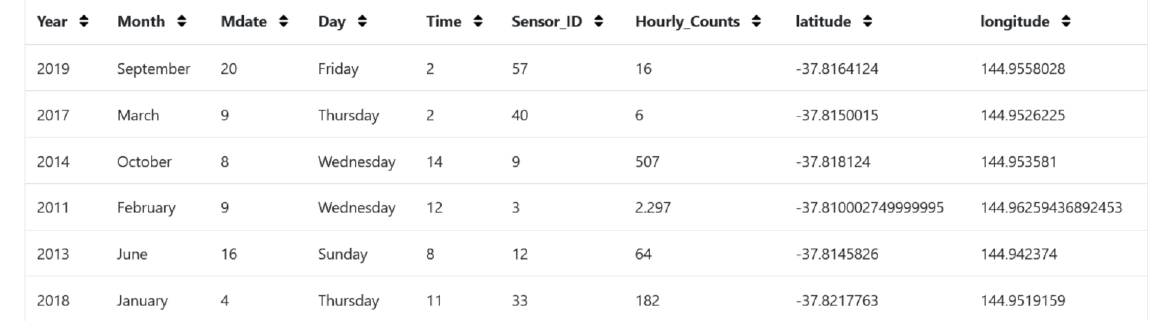
Figure 3. The face recognition algorithm applied to a frame of a crowd at a country fair. The average number of faces detected per frame is used to estimate the people density in the